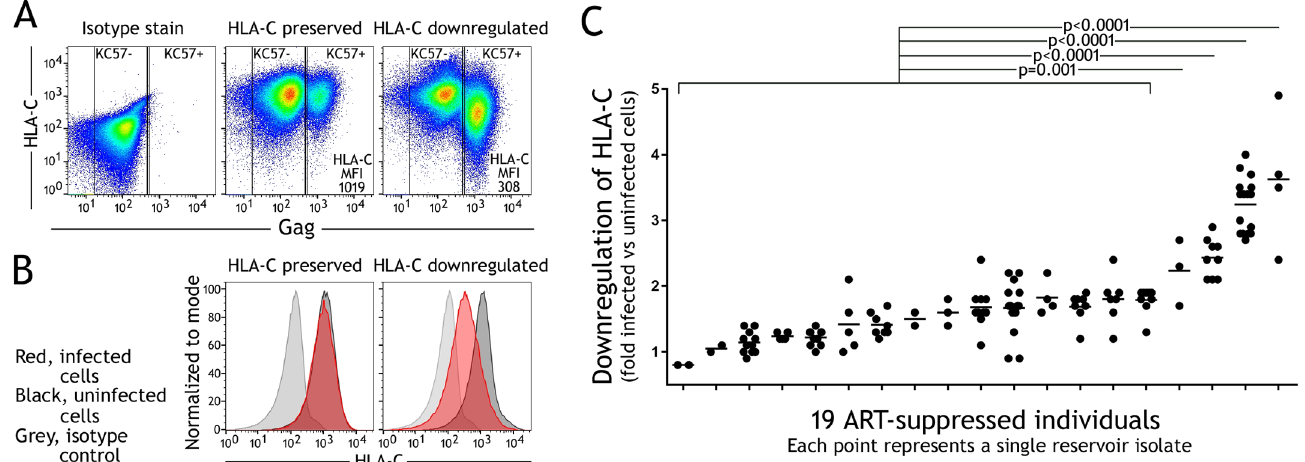
Fig 1. Inducible infectious HIV-1 reservoir viruses can downregulate HLA-C. (A) Viral isolates were generated from ART-suppressed individuals and infected co-cultured Molt-4 cells, where HLA-C downregulation was determined by comparing HLA-C staining between uninfected and infected cells, discriminated by intracellular staining for Gag. (B) Representative staining of Molt-4 cells in cultures infected with viral isolates that preserve or downregulate HLA-C. HLA-C staining is shown for infected (red) and uninfected cells (black) compared to an isotype control stain (grey). (C) HLA-C downregulation observed for 128 isolates from 19 individuals. Statistical analyses are unpaired t tests.